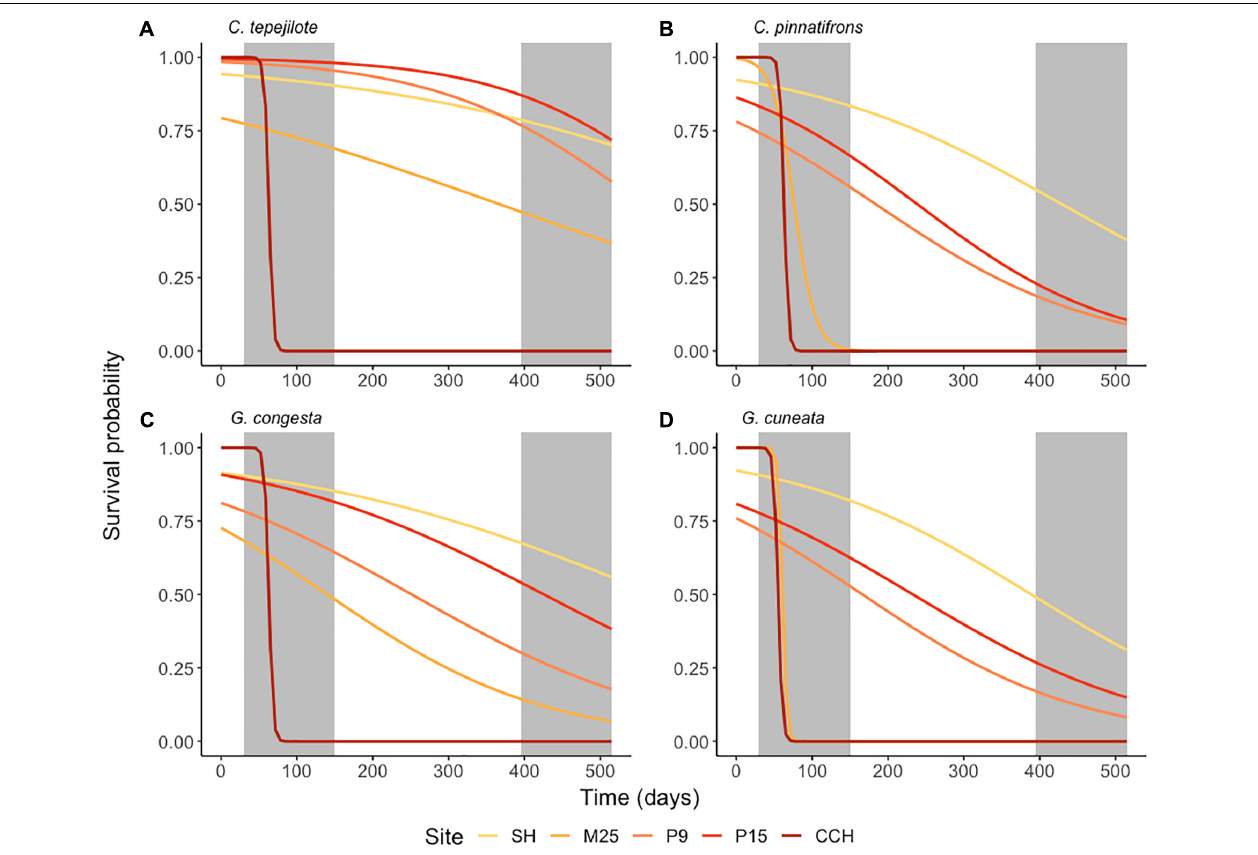
FIGURE 5 | Field transplant experiment of seedling survival of four understory palm species, (A) Chamaedorea tepejilote , (B) C. pinnatifrons , (C) Geonoma congesta , and (D) G. cuneata . Seedlings of each species were grown at each of five sites that differed in soil fertility. Percent survival is based on the species mean per garden per site. Curves for each species are the outputs from generalized linear models (Survival rates ∼ Site). Shading of the curve increases intensity with soil nutrient availability from SH to CCH. Gray shaded boxes represent dry seasons in year 1 and 2 of the field